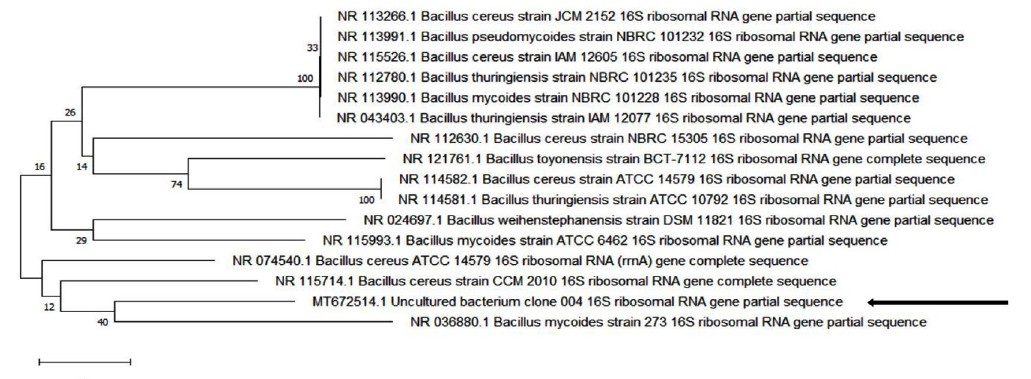
Fig. 1 (a) . Phylogenetic tree for ECd004. The scale bar indicates 1 change per nucleotideposition (evolutionary distance).